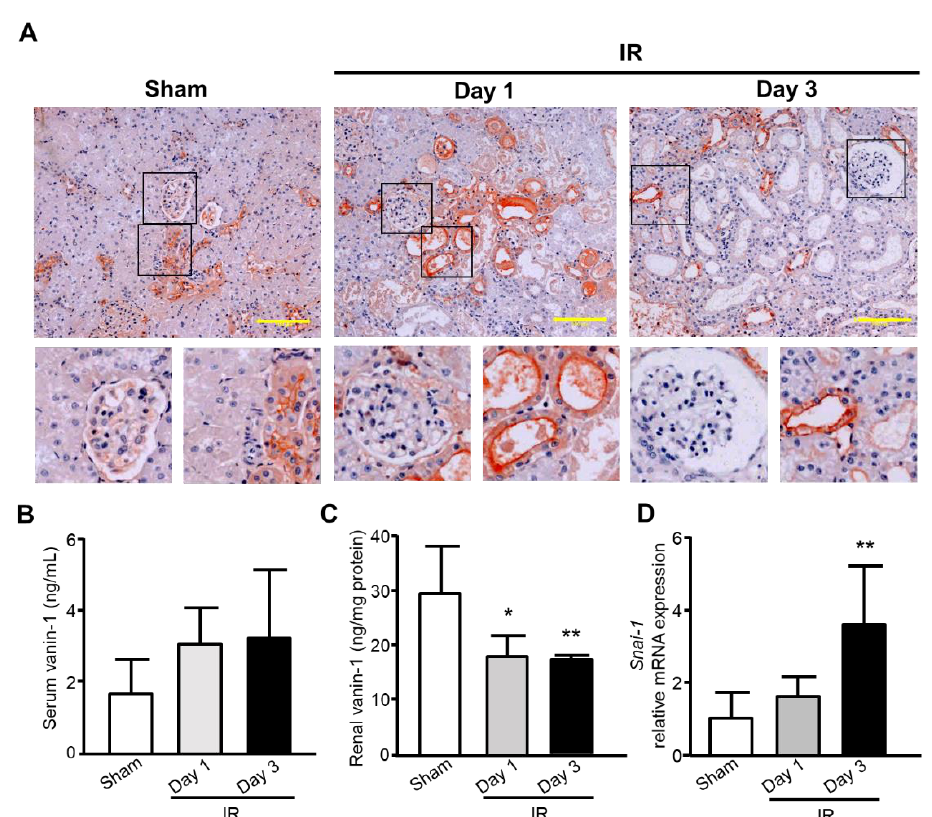
Figure 3. Evaluation of renal and serum vanin-1 and progression to EMT after I/R-treatment. ( A ) Representative immunostaining of vanin-1 in the kidney of rats. Vanin-1 expression was localized both around the injured tubules and within a subset of injured tubules, but not in the glomeruli. Scale bar, 100 μm. ( B , C ) Serum and renal vanin-1 were determined. ( D ) The mRNA level of snail family zinc finger 1 ( Snai1 ) was determined using real-time quantitative PCR. The mRNA expression level was normalized to that of Gapdh . Sham-operated rats, n = 6; I/R-treated rats, n = 5. * p < 0.05; ** p < 0.01 vs. sham-operated rats.